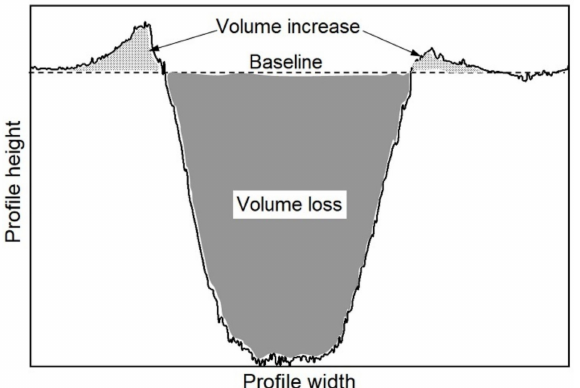
Figure 4. The scheme of the volumetric wear calculation using the wear track’s